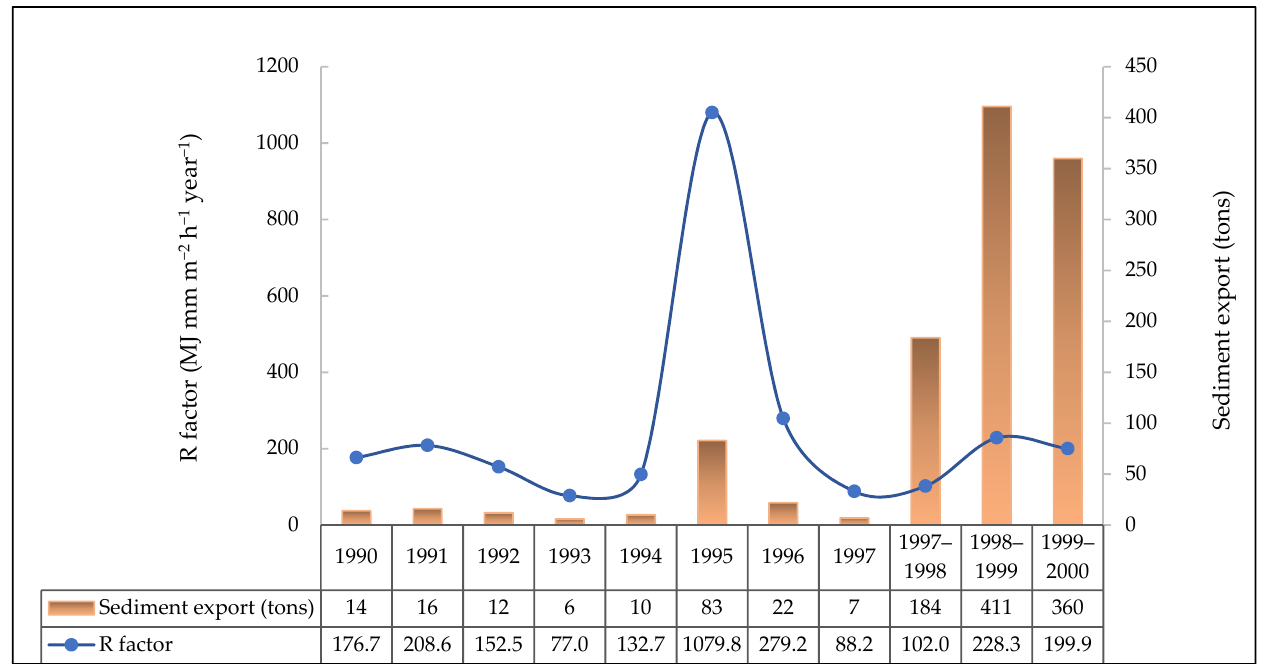
Figure 5. Modeling sediment export results relative to the annual R factor values.